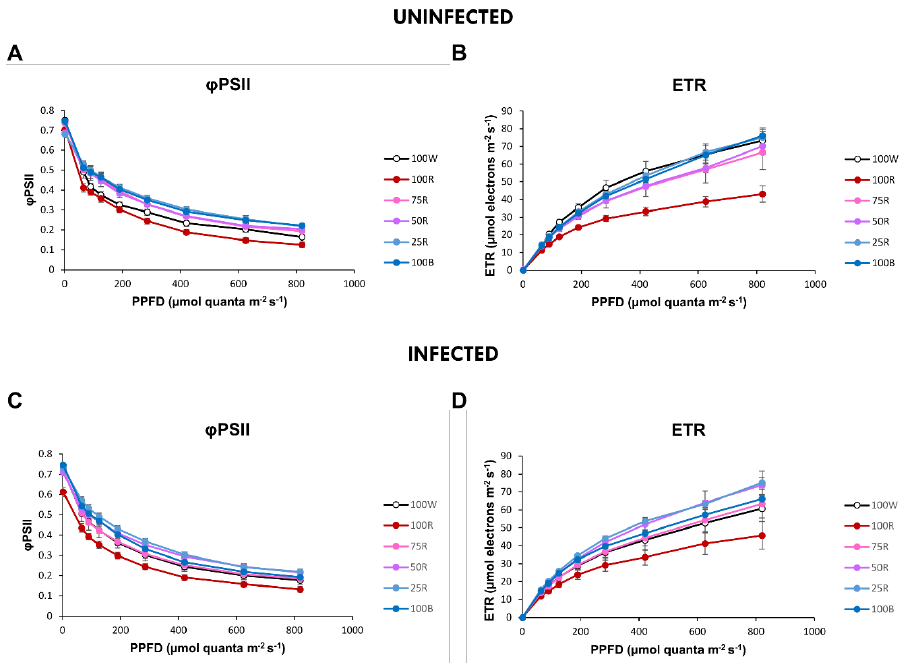
Figure 4. Effect of light quality on Φ PSII ( A , C ) and ETR ( B , D ) response to photosynthetic photon flux density (PPFD) on the uninfected and infected groups, respectively. The values are presented as the mean of 4 – 5 biological replicates ± SE. For statistical analysis see Supplementary Table S1.